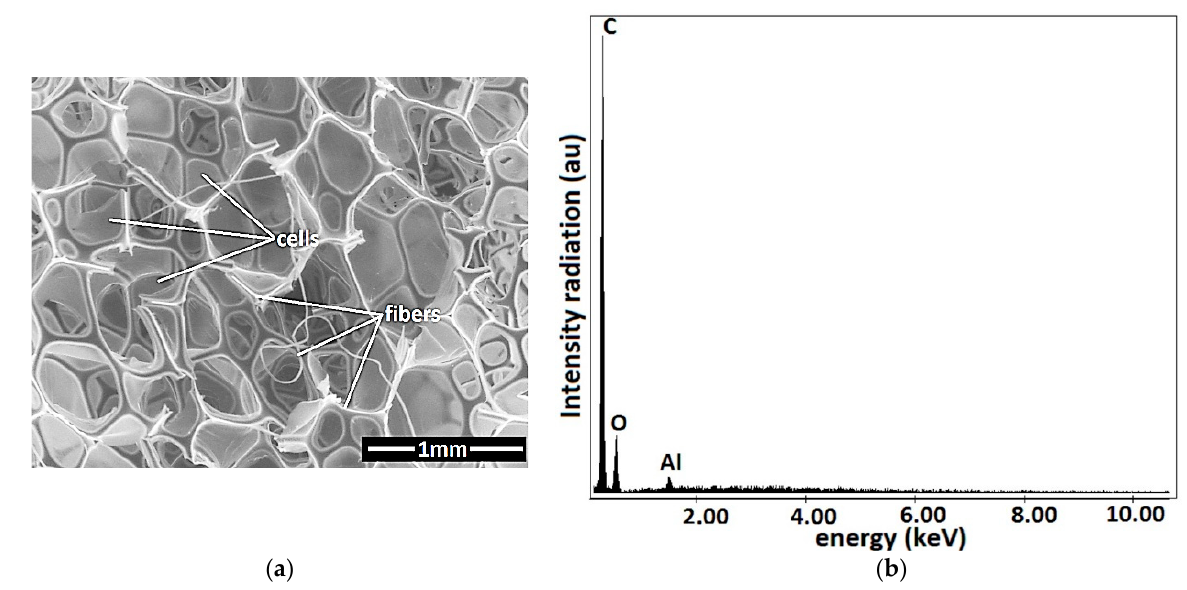
Figure 4. ( a ) SEM morphology of PS; ( b ) EDX spectra for the elemental analysis of